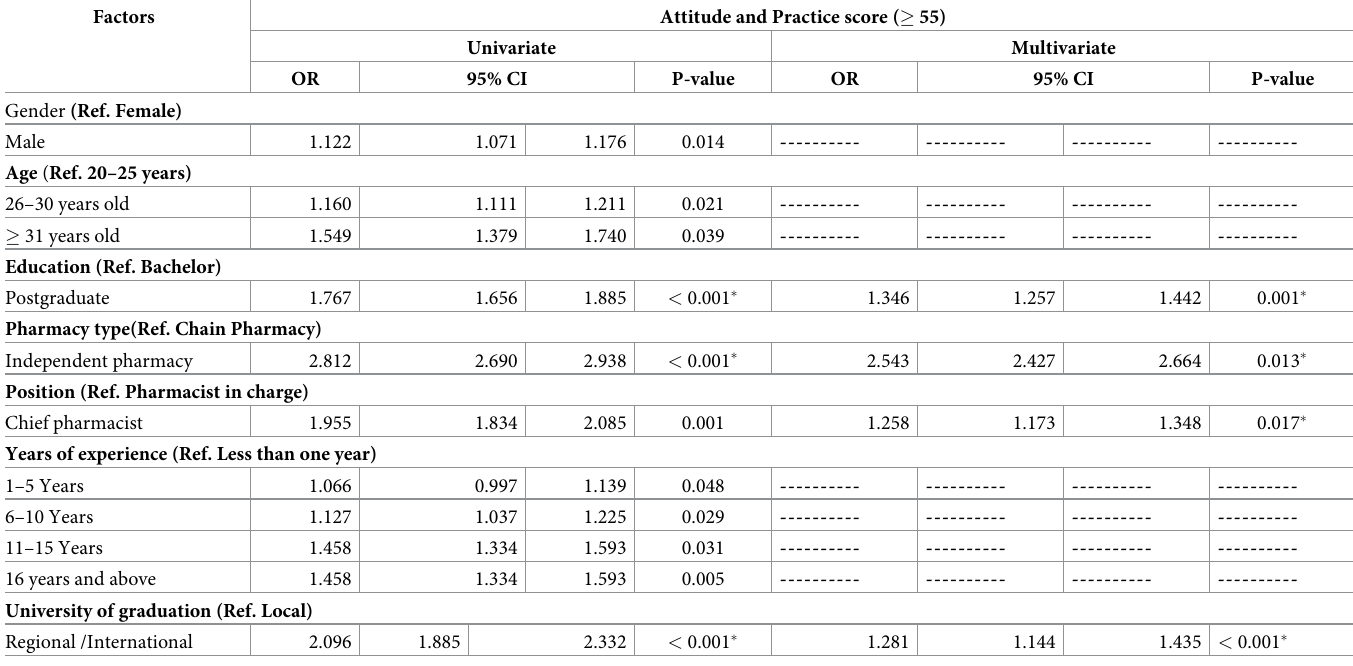
Table 3. Univariate and multivariate analysis of factors associated with attitude and practice about disaster medicine preparedness and readiness.